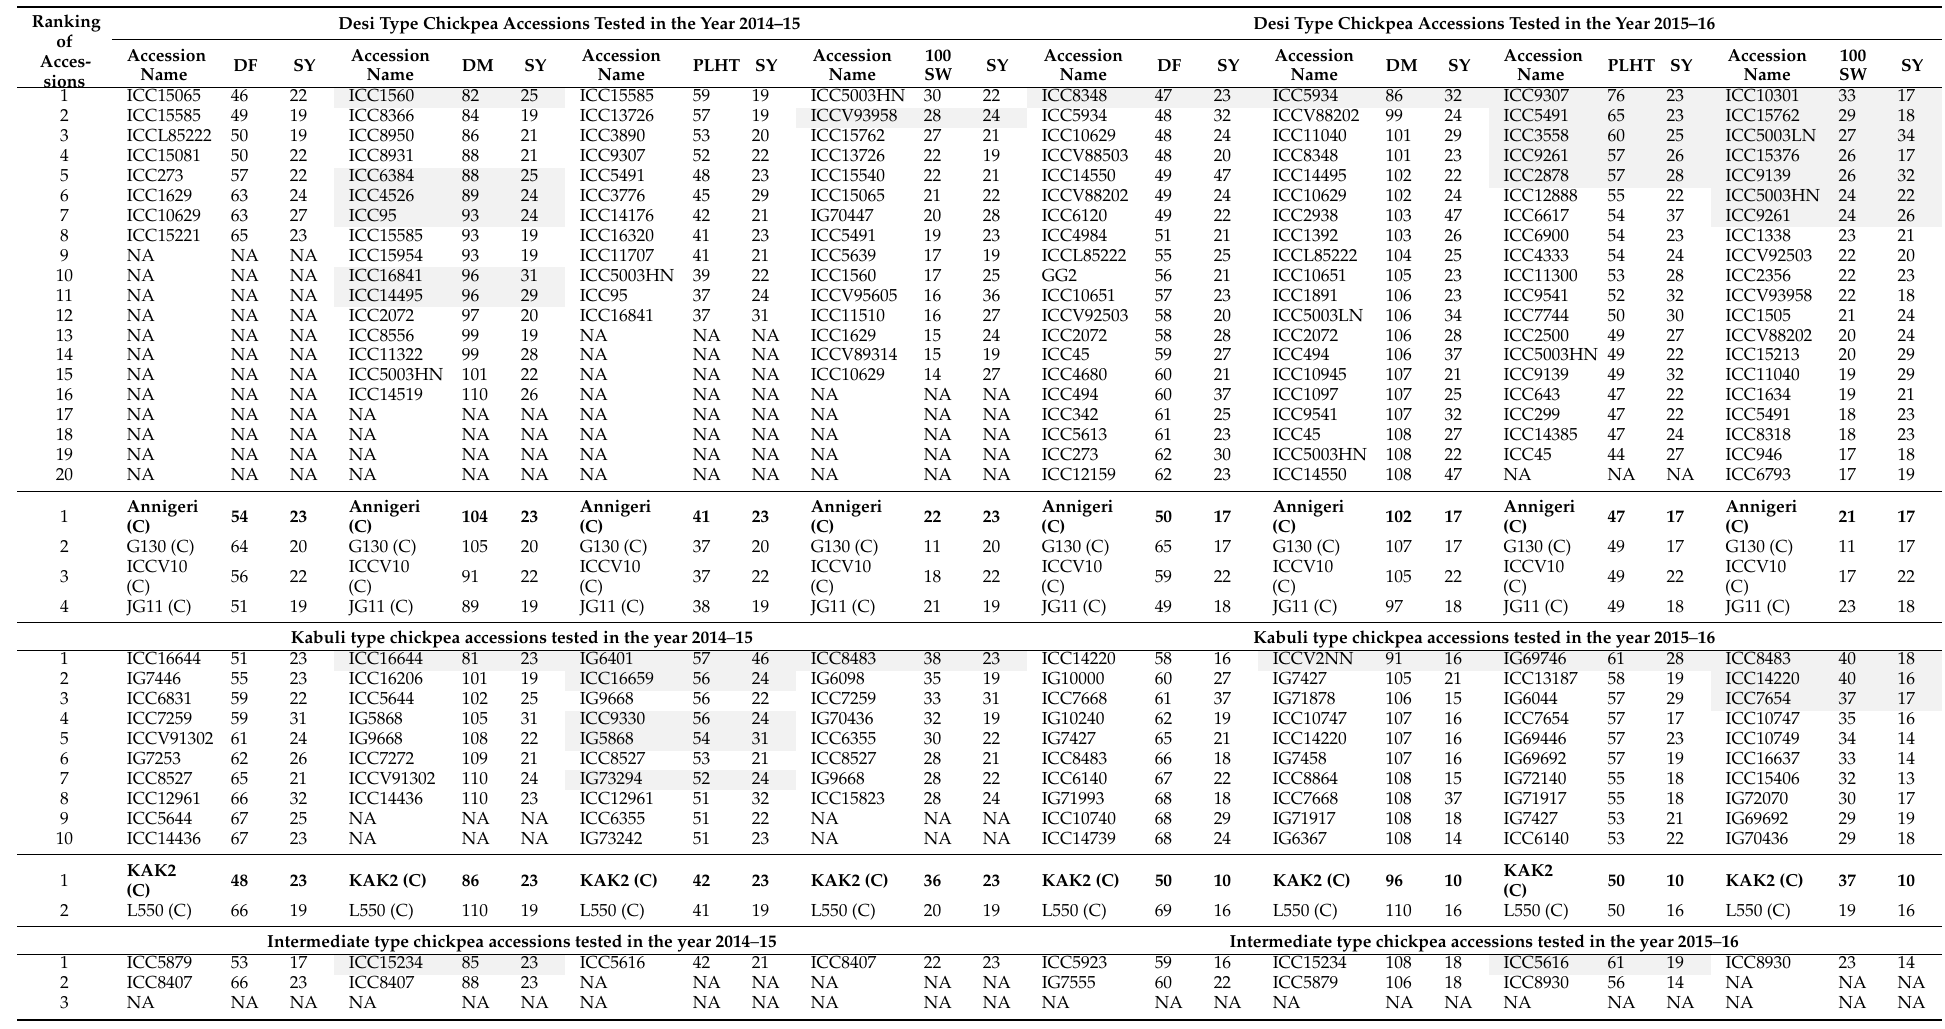
Table 6. Shortlisted germplasm accessions based on ranking biplot for five traits across two years for Junagadh,